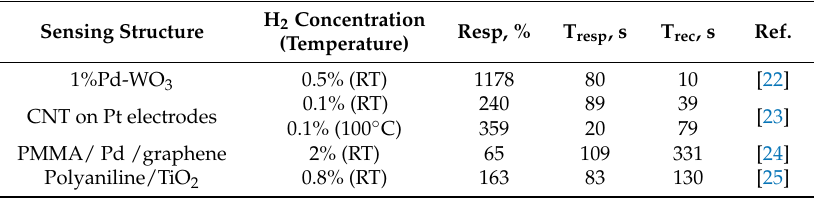
Figure 3. Possible mechanism of sensor operation based on our experimental observations and the properties of carbazole. Table 2. Comparison of the parameters of existing RT H 2